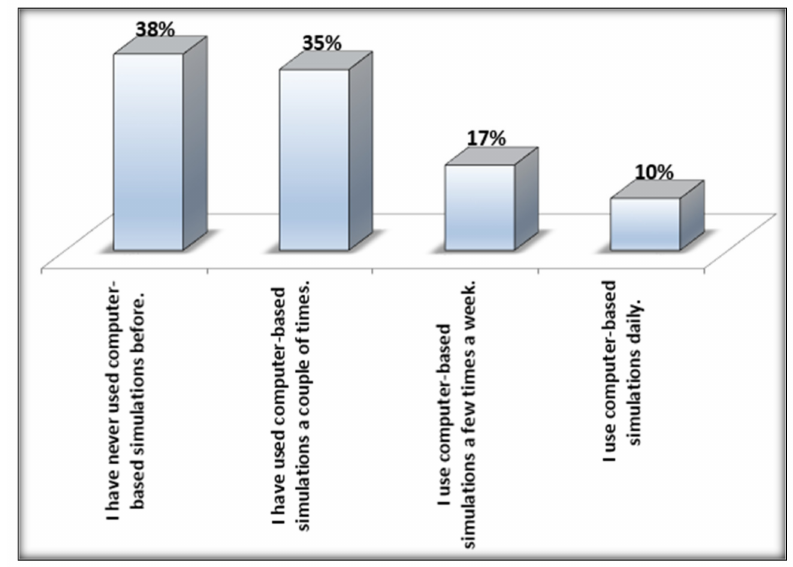
Figure 3. Study participants’ prior experience of using